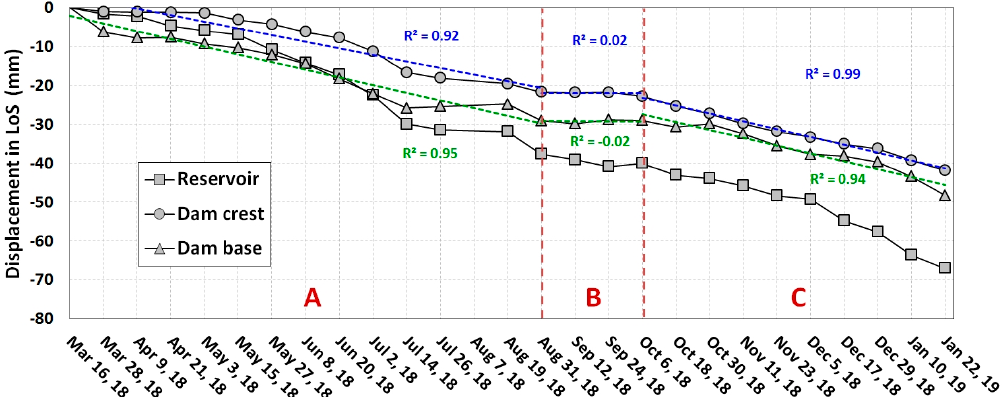
Figure 10. Time-series PSI LoS displacements for three selected points located at three sectors of Dam-I as presented in Figure 8a showing the highest cumulative displacements for the entire period of monitoring and the linear regression of the data (letters A, B, and C are the deformation trends as discussed in text).